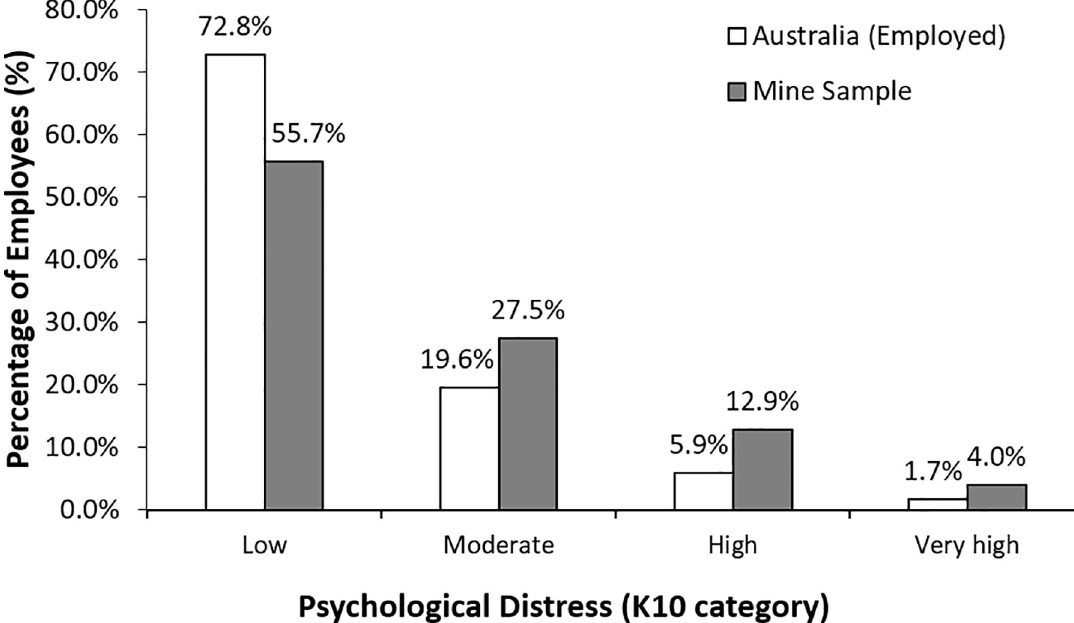
Fig 1. Psychological distress (K10) in metalliferous mines compared with an age and gender weighted sample of employed Australians.